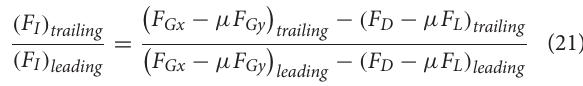
at longer glide distances, the relative change of 1 x is slightly smaller than the one of ρ